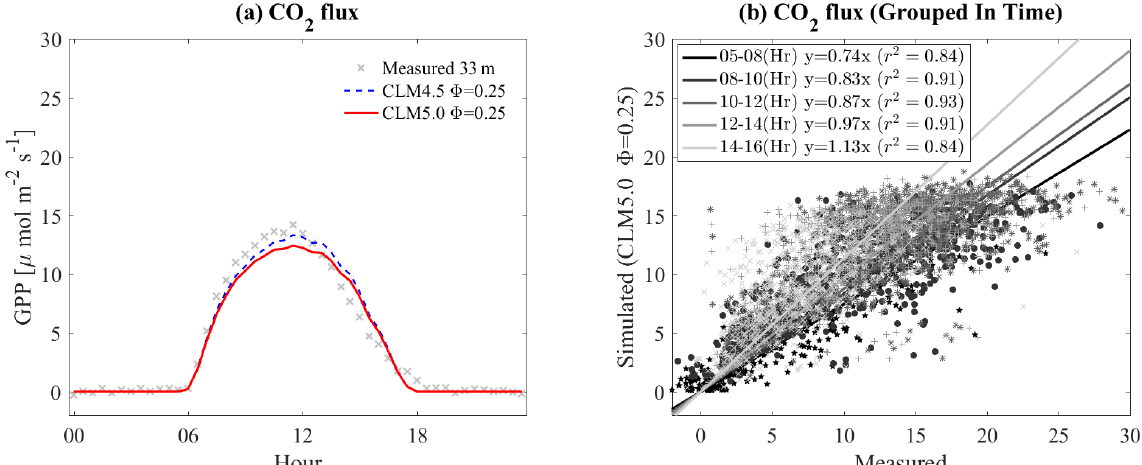
Figure 6. Test simulation using (cid:56) = 0 . 25 and (cid:50) = 0 . 7 as in Fig. 5d. By the modification of (cid:56) , maximum GPP has been reduced. It is possible to improve this model by updating (cid:50) ; r 2 is an R -squared value without an intercept. The units for both (a) and (b) are the same (µmolm − 2 s − 1